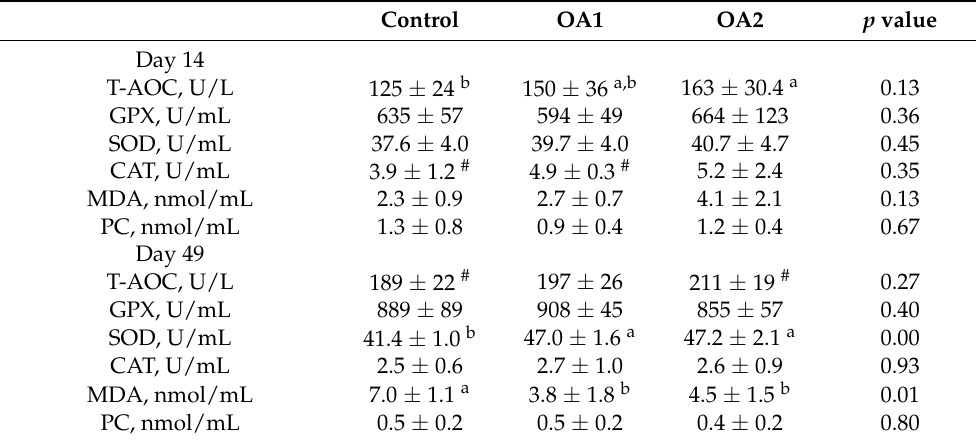
Table 2. Effects of organic acids on the serum antioxidant indexes 1 .